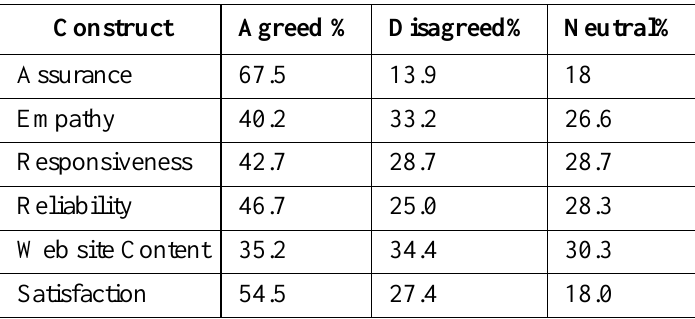
Table 02: Summary of Descriptive